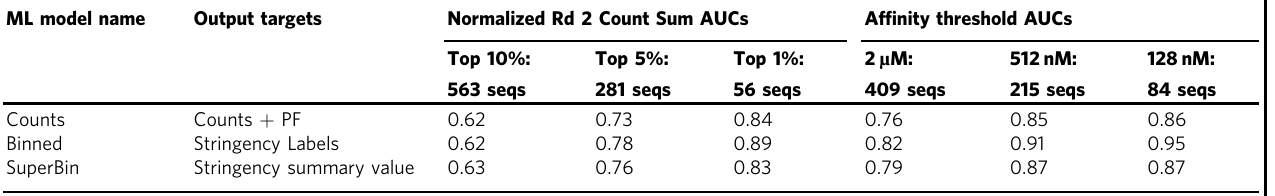
Table 1 Test set AUC using two different criteria.